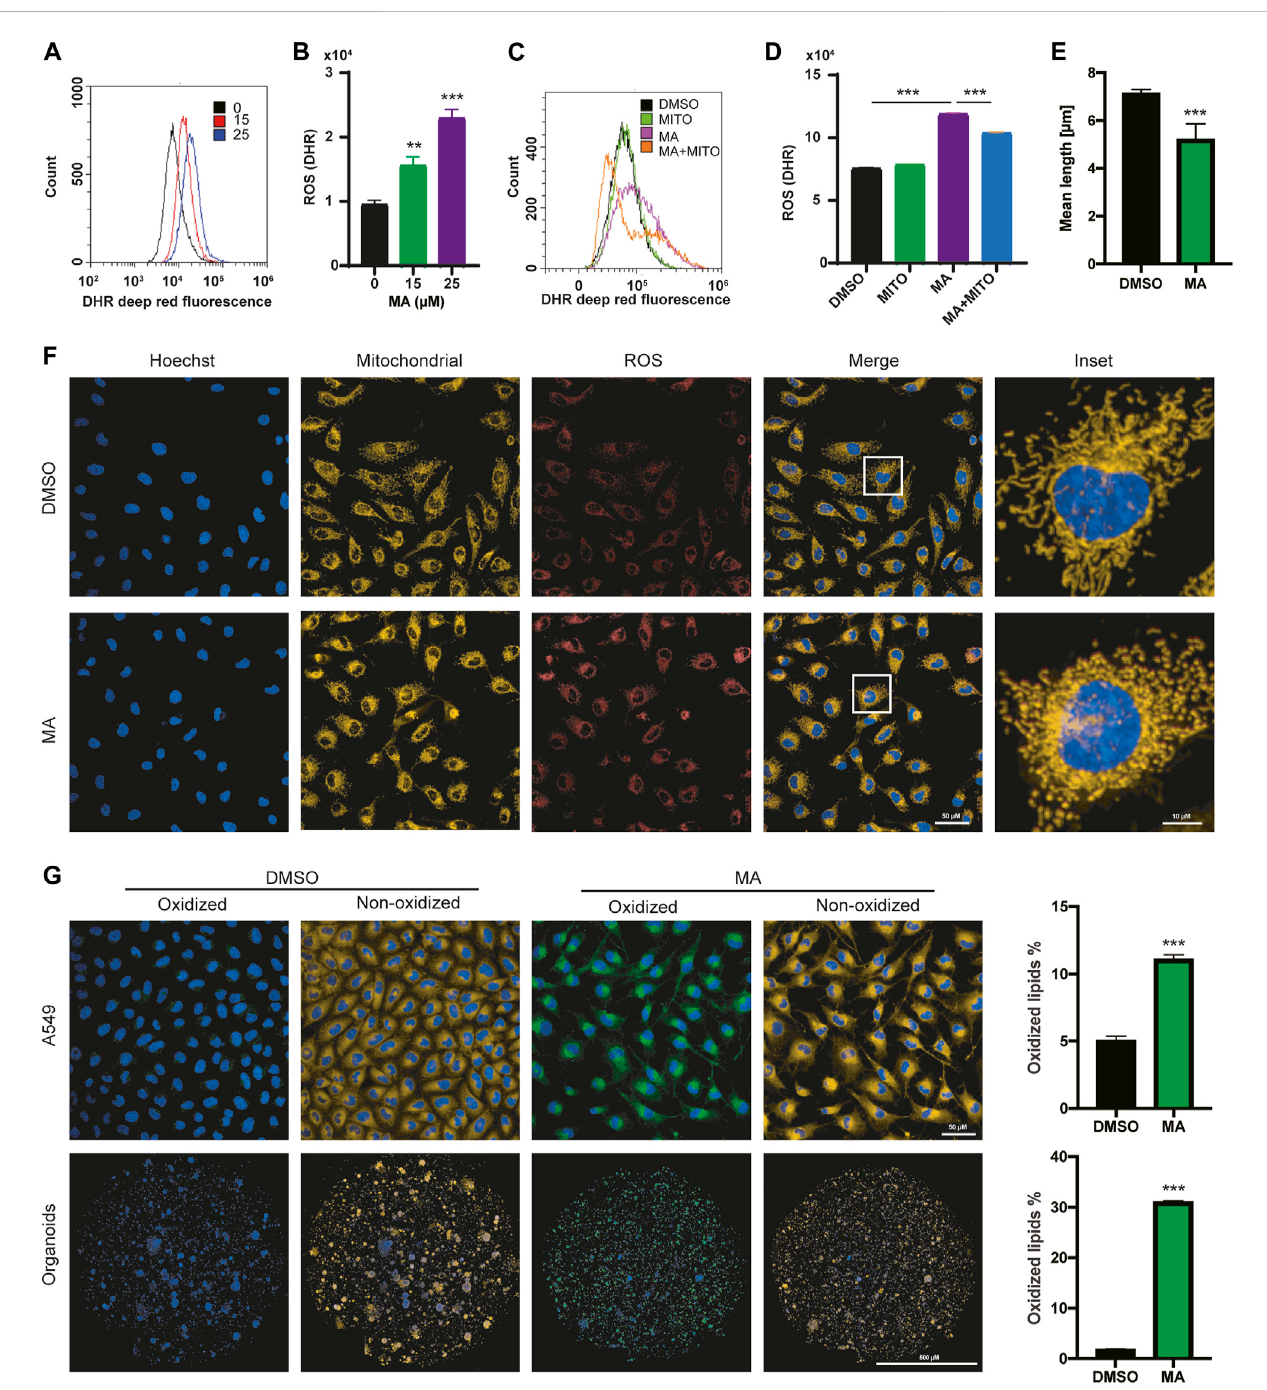
FIGURE 3 MA induces mitochondrial ROS elevation and lipid peroxidation. Representative fl ow cytometry histogram (A) and quanti fi cation of DHR (ROS marker, deep red) (B) in A549 cells treated with different concentrations of MA. Representative fl ow cytometry histogram (C) and quanti fi cation of DHR (ROS marker, deepred) (D) inA549cellstreatedwithmitoTEMPO(1 μ M)andMA(15 μ M). (E) Quanti fi cationofmitochondriallengthinA549cellstreatedwithMA(15 μ M). (F) Representative confocal fl uorescence microscopy images of mitochondria and ROS. (G) Representative confocal fl uorescence microscopy images and quanti fi cations of lipid peroxidation staining with BODIPY 581/591 C11 in A549 cells and organoids treated with MA (15 μ M). ** p < .01, *** p <